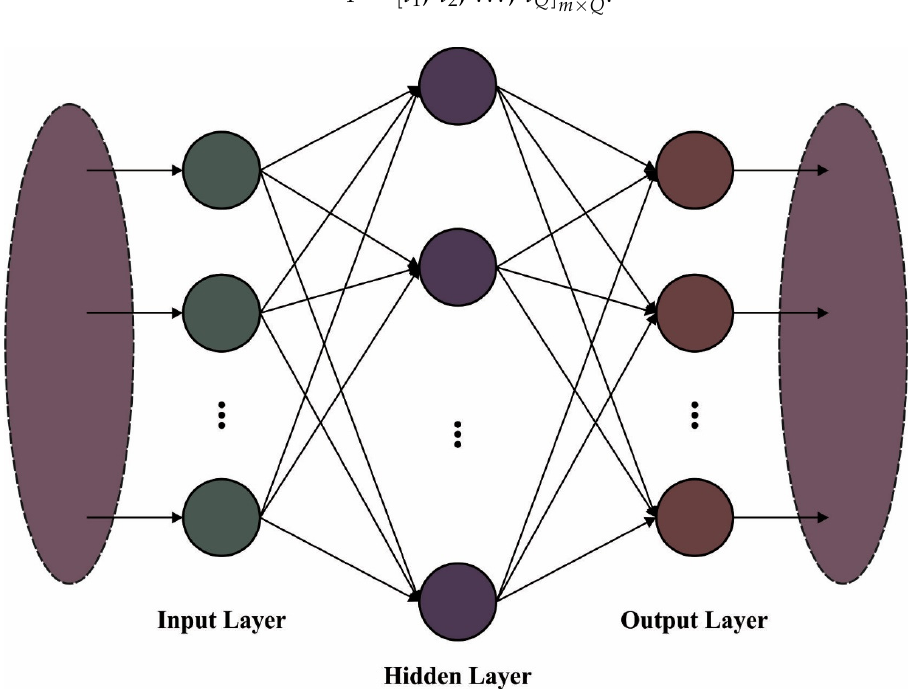
Figure 2. Framework of ELM.